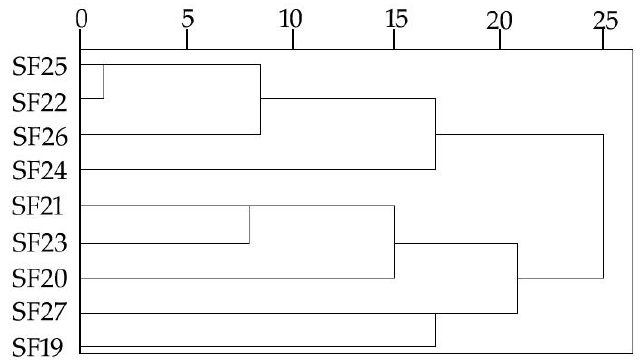
Figure 1. The cluster results of important project-related factors.